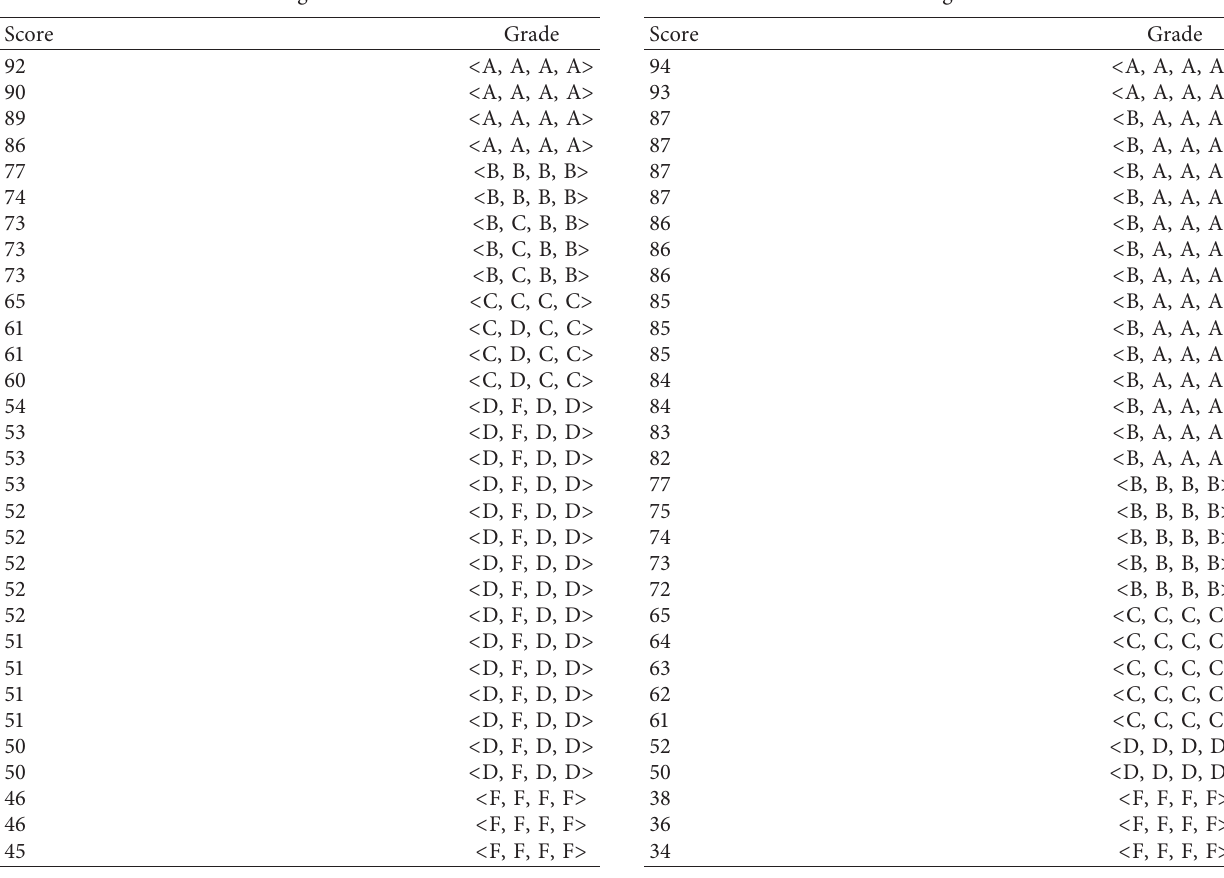
Table 8: Grading results of SD+. Table 9: Grading results of SD − .